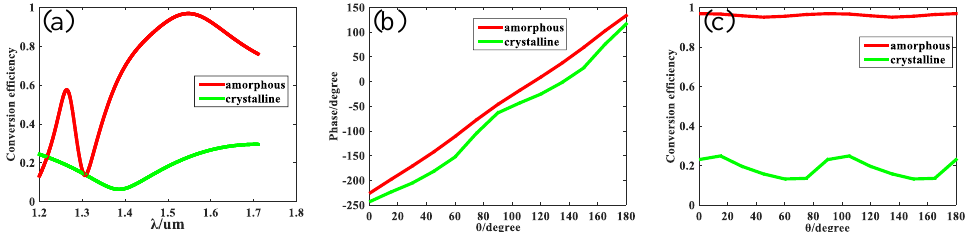
Figure 6. ( a ) The conversion efficiency from LCP to RCP versus wavelength for unit cell U 2 when GST stays in different states. ( b ) The phase modulation of unit cell U 1 versus rotating angle θ for different states of GST at the designed wavelength of 1.55 μm. ( c ) The conversion efficiency of unit cell U 1 from LCP to RCP versus rotating angle θ for different states of GST at the designed wavelength of 1.55 μm. Metalens M 3 is constructed by unit cells U 1 and U 2 together. Unit cells U 1 are arranged in section A as x d = 5 μm, y d = 0 , f = 20 μm, and unit cells U 2 are arranged in section B as x d = − 5 μm, y d = 0 , f = 20 μm. Figure 3d is the overview of the metalens, in which the green structures represent U 1 and the red structures represent U 2 . The phase distribution of the metalens M 3 along the x axis is depicted in Figure 3e.